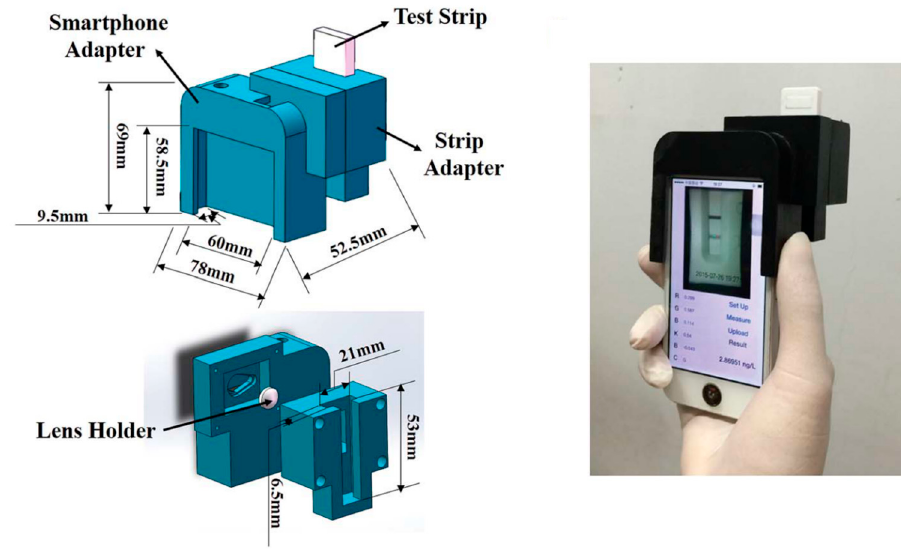
Figure 5. The on-site marine toxins diagnostic adapter developed by Fang et al. Adapted from [24] DOI: 10.1039/c2lc41152k with permission from The Royal Society of Chemistry. All rights reserved.